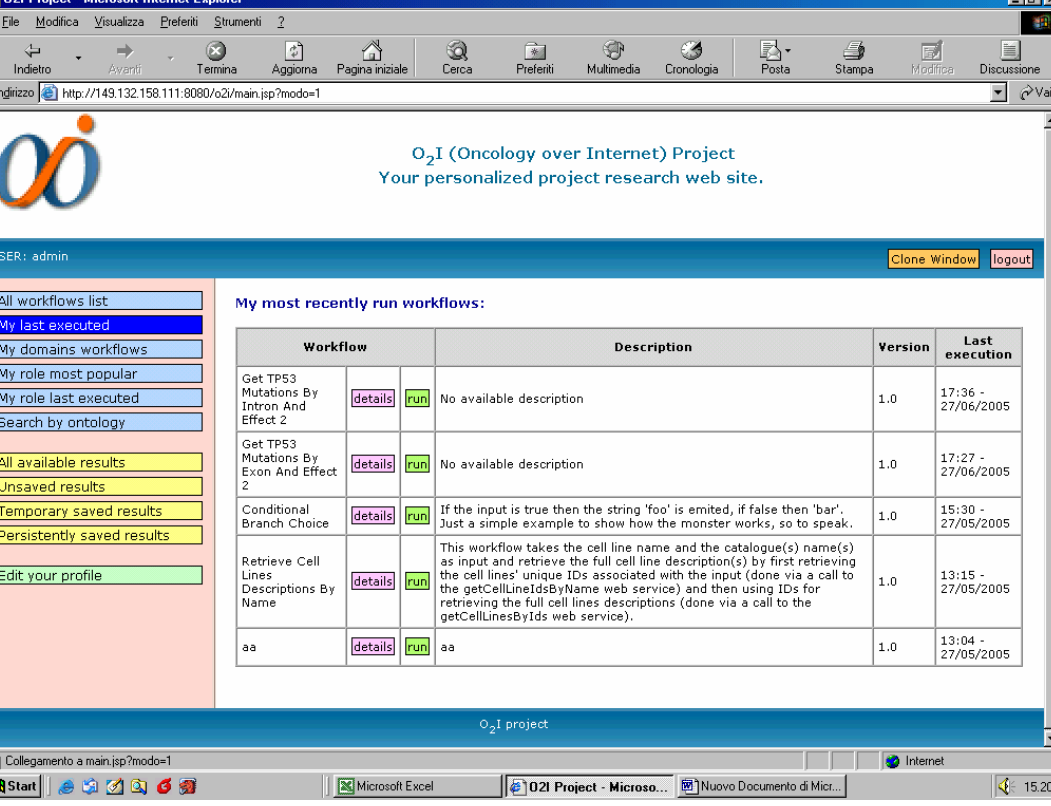
Figure 2: list of most recently executed workflows as they appear in the user